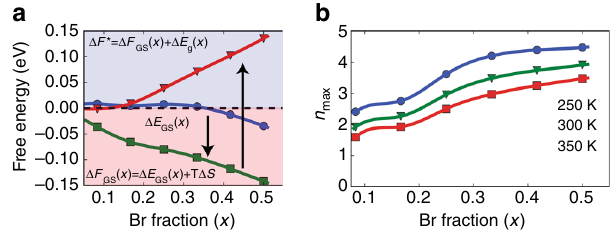
Fig. 3 Density functional theory modeling of halide phase segregation. a Estimated free energy of formation as a function of bromide fraction x . The blue line / circles are generalized gradient approximation (GGA)- computed 0 K ground state formation energies, including spin-orbit coupling. The green line/squares are free energies of mixing at 300 K, assuming ideal mixing on the halide sublattice. The red line / inverted triangles represent the free energy difference after single photon absorption. All energies are reported per two formula units. Blue and pink shaded areas indicate positive (phase separation favored) and negative (phase separation disfavored) free energy regions. b Approximate size of separated domains, n max , following single (cid:5) ; which increase with x , capture the demixing driving force. Consequently, the free energy change associated with the transformation of n formula units of photoexcited MAPb(I 1 − x Br x ) 3 into pure bromide and pure photoexcited iodide ( Δ F * ) can be written as Δ F (cid:3) x ; n ð